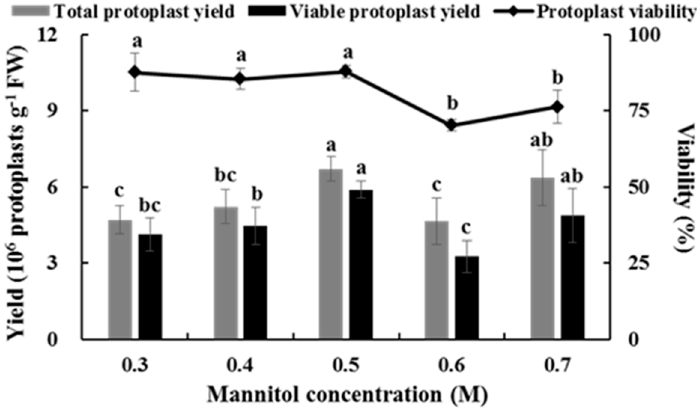
Figure 3. Effects of mannitol concentration on the yield and viability of Chinese kale hypocotyl protoplasts.